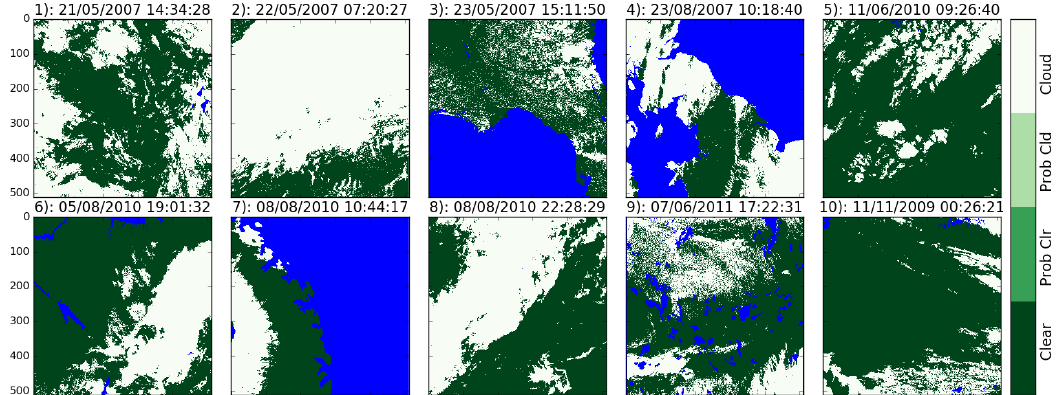
Figure 2. Manual cloud mask for the 10 submission scenes in the cloud clearing inter-comparison (Table 1) at native resolution ( ∼ 1 km). Individual plot headings give the scene number, date and orbit start time. Ocean and inland water bodies are plotted in